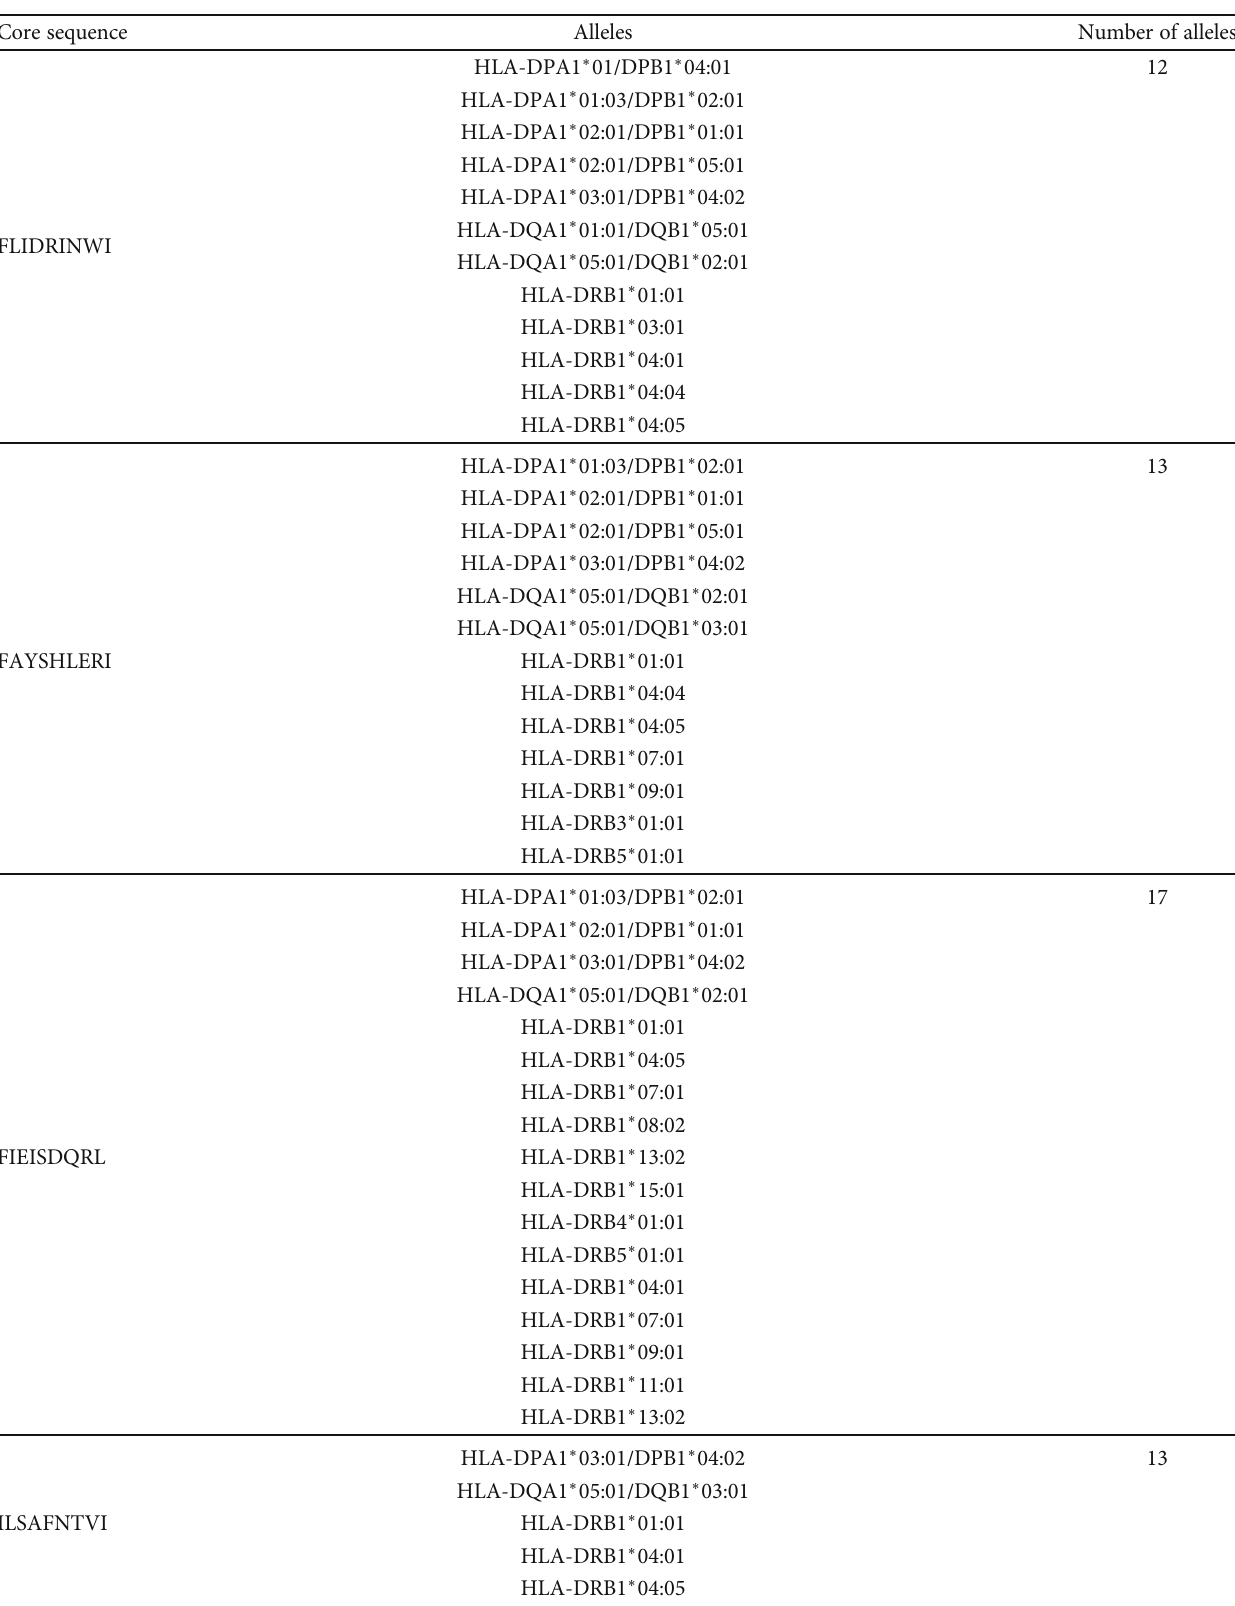
Table 3: The most potential T cell epitopes (core sequence) and the number of their binding alleles. Core